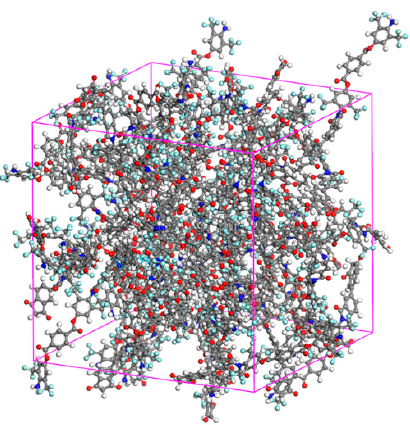
Figure 2. Randomly packed model compounds for PEsI–(CF 3 ) 1 in a 3D periodic boundary